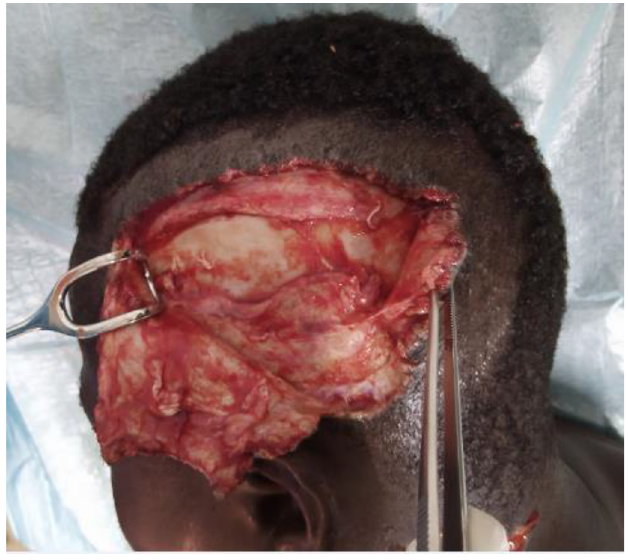
Fig. 1. Right temporoparietal tangential wound with exposure of the skull.